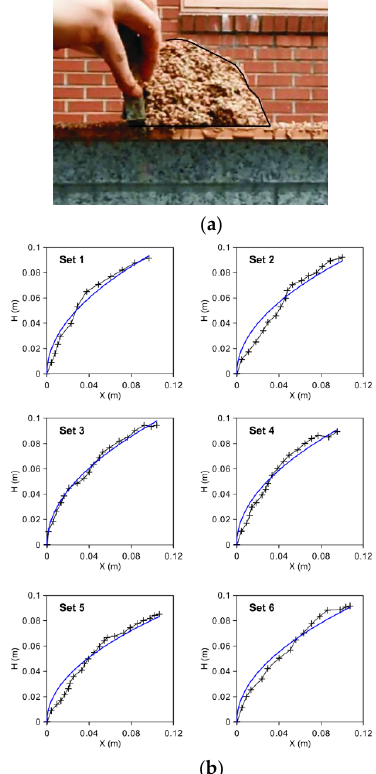
Figure 7. ( a ) Photo of test yield stress calibration. ( b ) The measured longitudinal profiles and fitting curves (blue line) of 6 sets for calibration of yield stress. (X: longitudinal coordinate, H: height of profile).